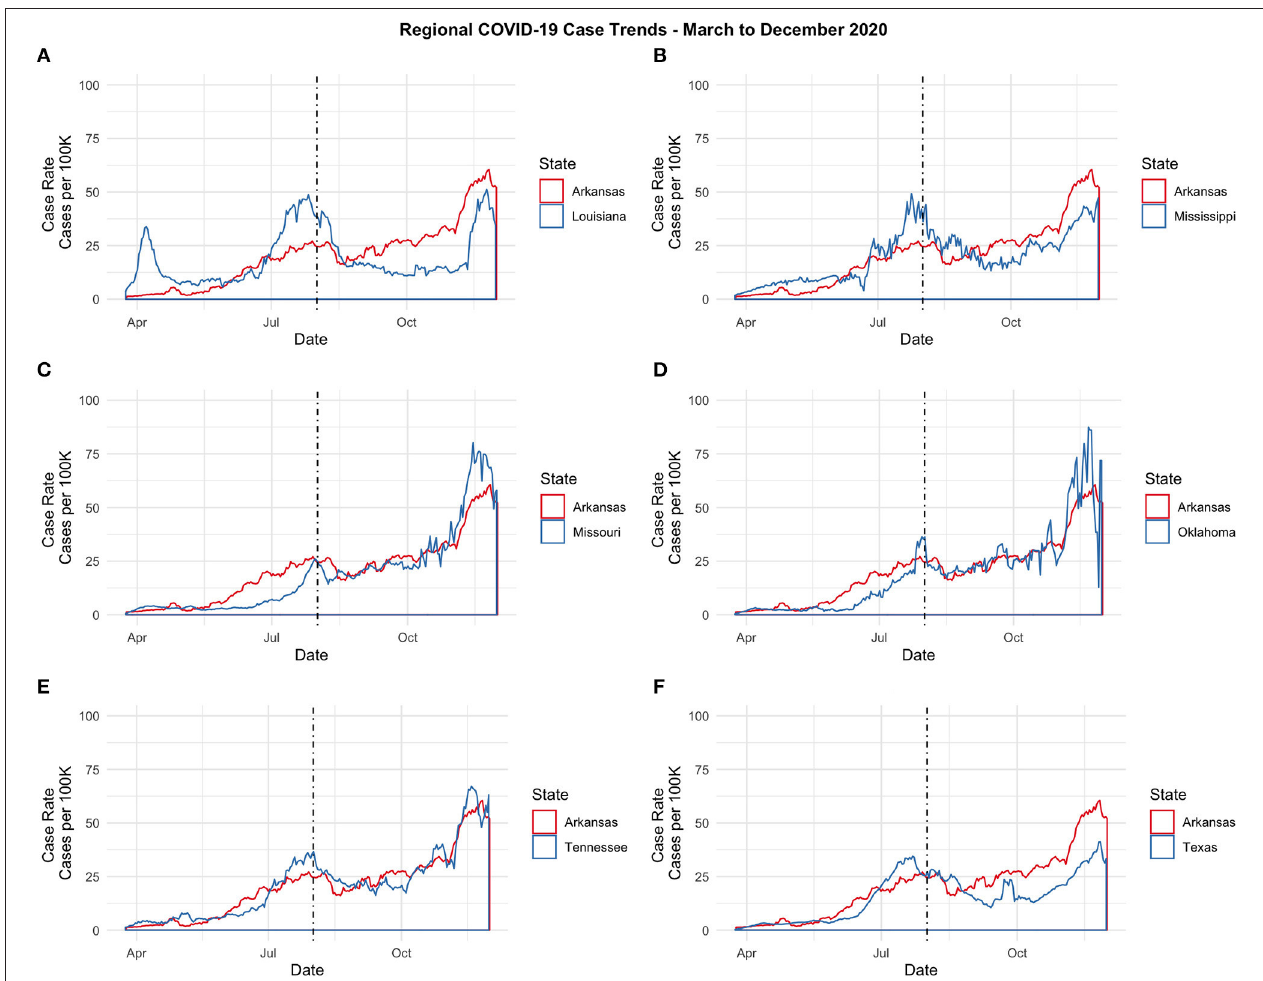
TABLE 1 | Means and standard deviations by state and time period for COVID-19 case and case rate 7-day moving averages. Overall ( N = 269)